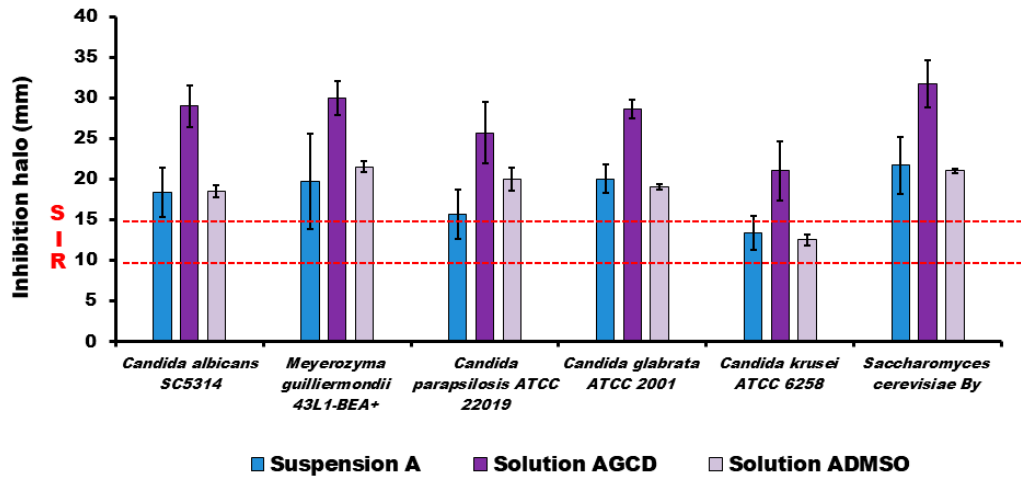
Figure 4. Antifungal in vitro activity of three liquid AmB formulations against different species of Candida and Saccharomyces cerevisiae ( Saccharomyces cerevisiae By ). Disks were embedded with 20 µL of AmB reference suspension (Suspension A), an AmB solution with cyclodextrins (Solution AGCD), or an AmB solution with DMSO. The growth inhibition halo diameters were measured at points where there was a complete inhibition of yeast growth. The isolates were classified as susceptible (S) to AmB when the inhibition zone was ≥ 15 mm, resistant (R) when it was ≤ 10 mm, and intermediate (I) or susceptible-dose dependent when the inhibition zone was between 10–14 mm [19]. Growth inhibition halo diameters are expressed as mean ± standard deviation (SD) are in mm. Each experiment was performed in triplicate. No antifungal activity, measured as halo inhibition (<1 mm), was observed with Orabase ® , DMSO, and γ -cyclodextrins products.